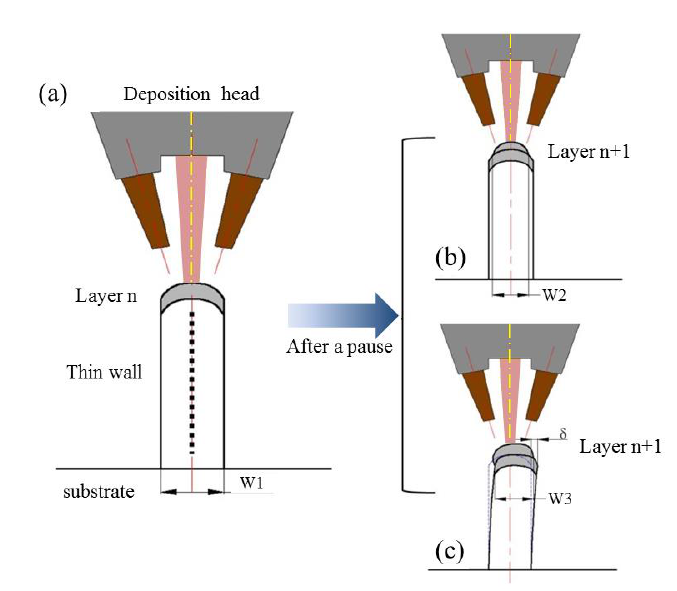
Figure 7. Schematic of the effect of the pause during thin-wall deposition on the dimensional accuracy: (a) ideal deposition process of thin wall sample ( b ) continue deposition after a pause on thin wall with enough stiffness ( c ) continue deposition after a pause on thin wall with low stiffness.